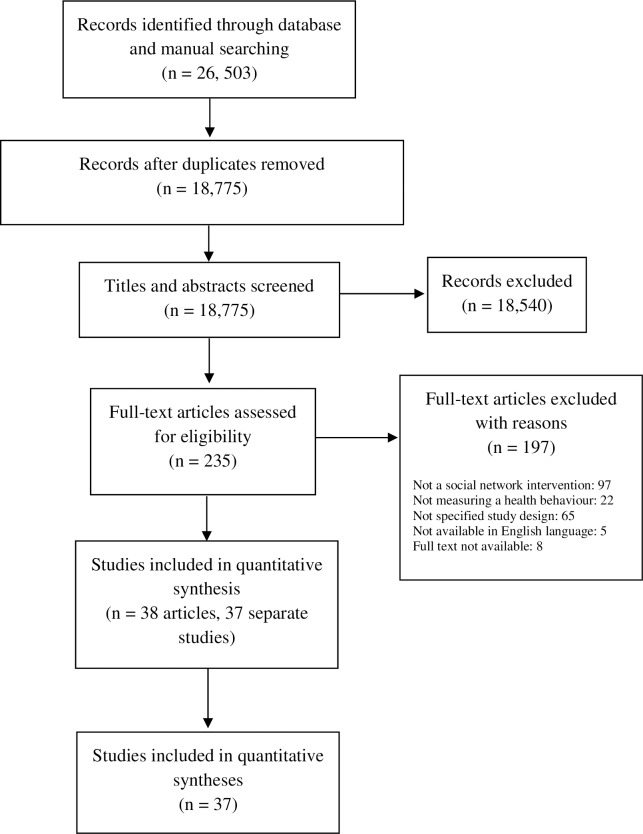
PRISMA flow diagram.PRISMA, Preferred Reporting Items for Systematic Reviews and Meta-Analyses.